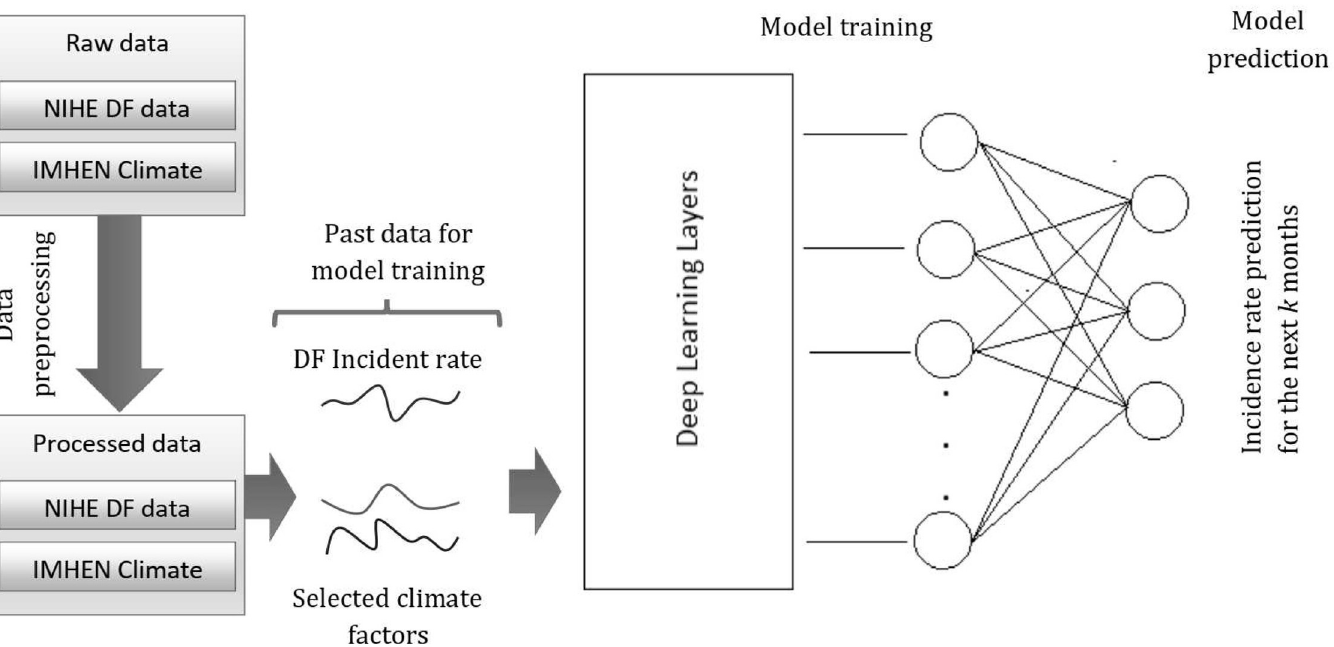
Fig 2. Data processing pipeline. NIHE = National Institute of Hygiene and Epidemiology. IMHEN = Vietnam Institute of Meteorology, Hydrology and Climate Change. DF = dengue fever.